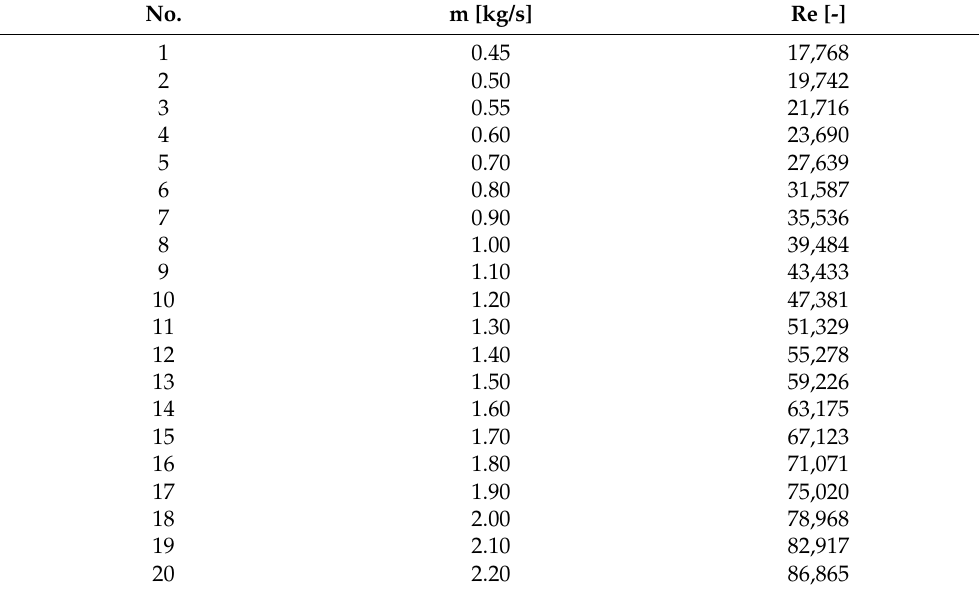
Table 4. Flowing water mass flux and the corresponding Reynolds